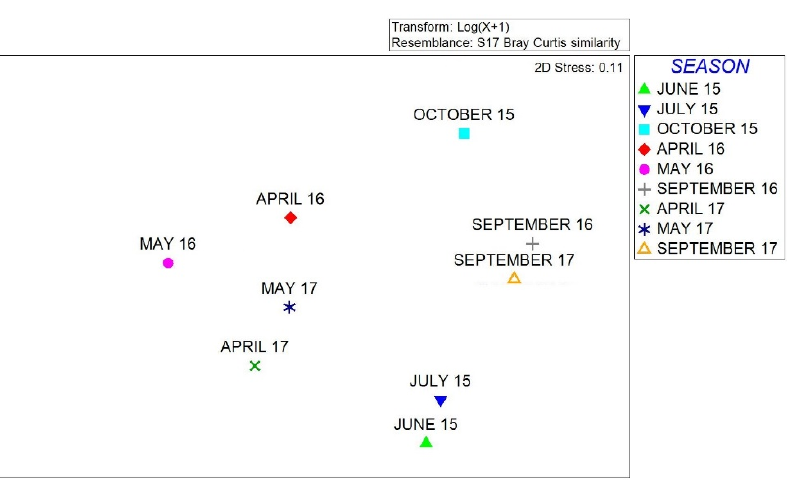
Figure 4. nMDS diagram, during the period of the nine sampling seasons (cluster analysis—group average linkage method). The nMDS was based on the Bray–Curtis similarity index after transforming the initial abundances x to the fourth root.